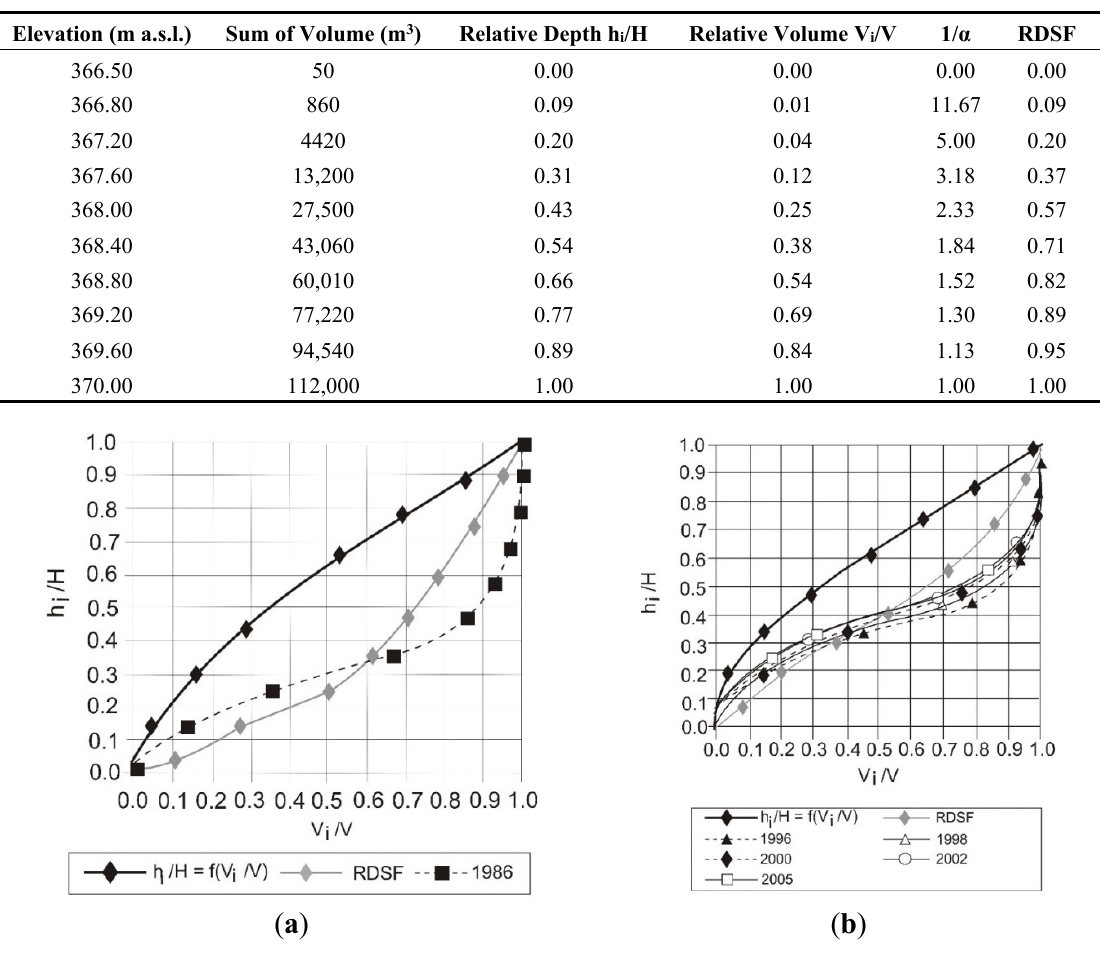
Figure 7. Comparison of cumulative depth of sediment deposition in Krempna reservoir, described with function h i /H = f ( V i /V ), with relative cumulative sediment distribution calculated according to Relative Depth Shape Function (RDSF) parameter; where h i /H is the relative depth, V i /V is the relative volume, and rel. V is the cumulative curve of the reservoir’s volume; ( a )—reservoir before dredging; ( b )—reservoir after